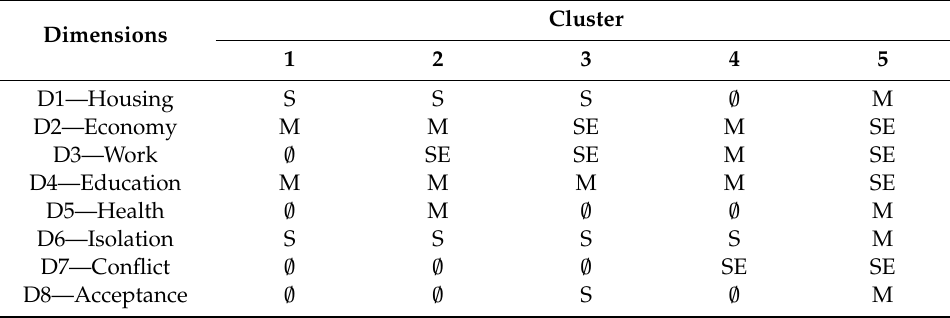
Table 4. Intensity of exclusion by center in the final clusters 1 .